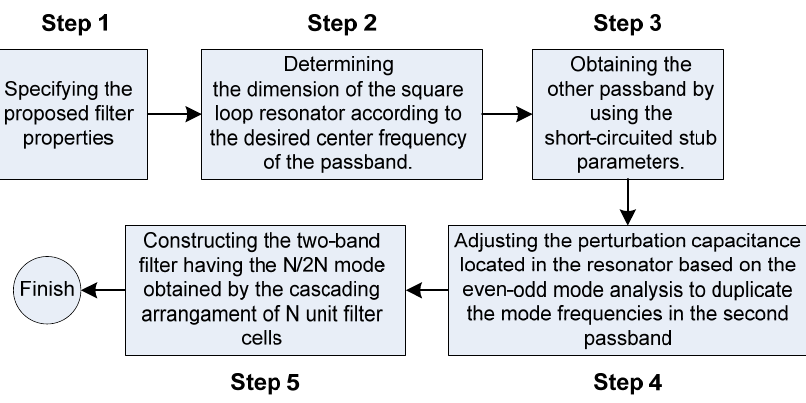
Figure 12. Design steps of the configuration of Nth/2Nth order two-band bandpass filter.